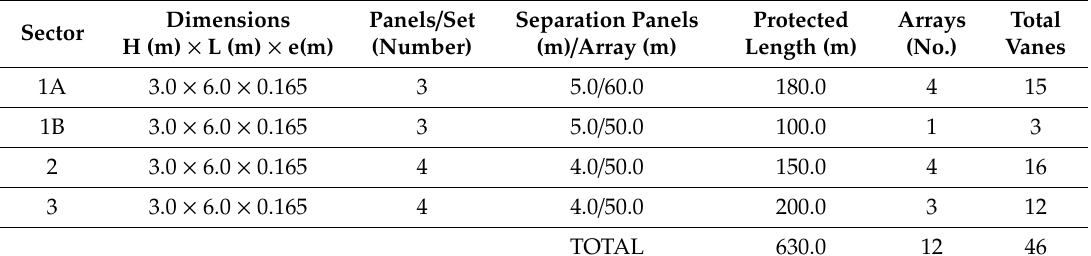
Table 1. Sinú River, Trementino: design of the submerged vane field (Hidroconsulta, 2004 [10]).